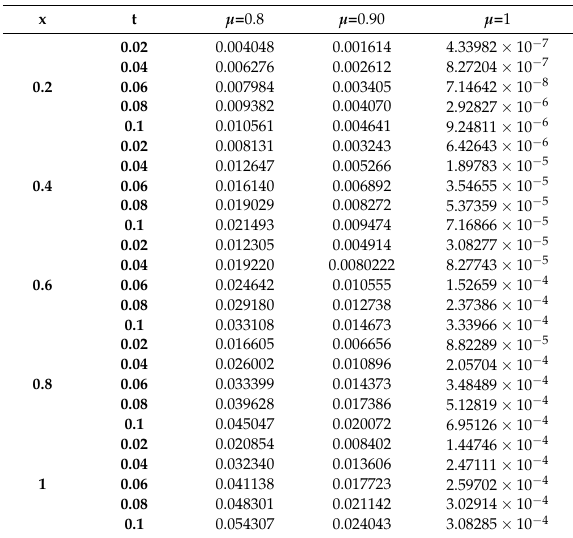
Table 1. Numerical simulations for fractional Kolmogorov–Petrovskii–Piskunov (FKPP) equation in terms of absolute error ( 0.5, (cid:125) = − 1, and n = 1 with distinct x and t for different µ